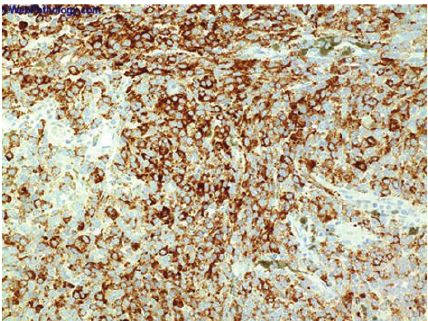
Figure 4: Bladder metastatic melanoma immunohistochemistry for HMB45. The differentiation of malignant melanoma from high-grade urothelial carcinoma may not be easy. Immunohis- tochemical staining for HMB-45 as depicted in the figure may help in the establishment of the correct diagnosis, taken from Bladder Melanoma Pathology http://outlines.com/, with permission to reproduce the figure from the original author source granted